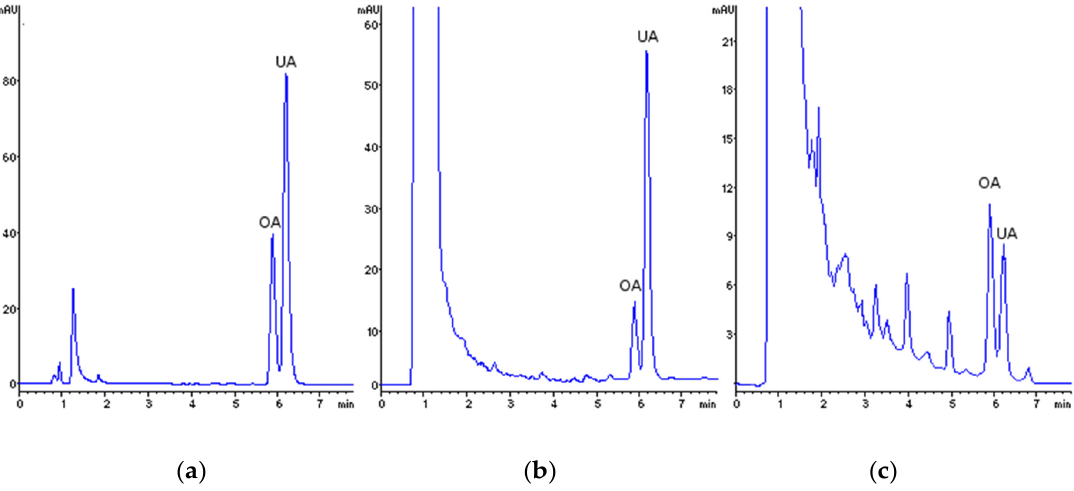
Figure 5. Representative chromatograms in the optimised conditions at λ = 215 nm of: ( a ) standards at concentrations of 149.40 μ g/mL (OA), 324.30 μ g/mL (UA), ( b ) A. uva ursi leaves (12 mg/mL), and ( c ) V. myrtillus leaves (30 mg/mL).